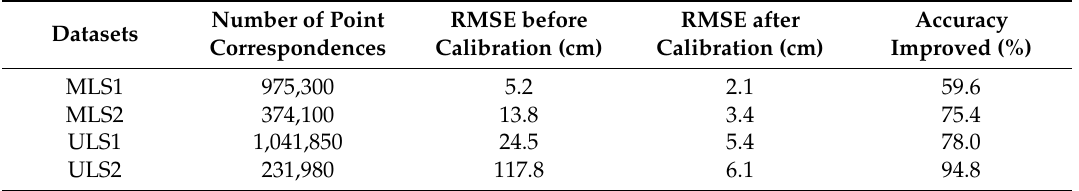
Table 3. The root mean square errors (RMSEs) of “MLS1”, “MLS2”, “ULS1”, and “ULS2” datasets. Datasets Number of point correspondences